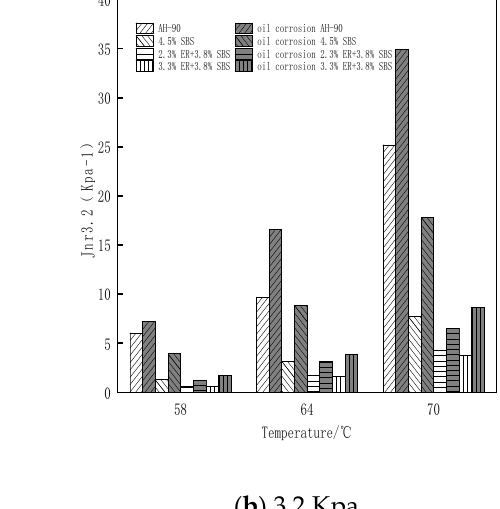
( b ) Figure 17. Effect of ER content on the low temperature performance of SBS modified bitumen: ( a ) Effect of ER content on the stiffness modulus; ( b ) Effect of ER content on the creep rate.